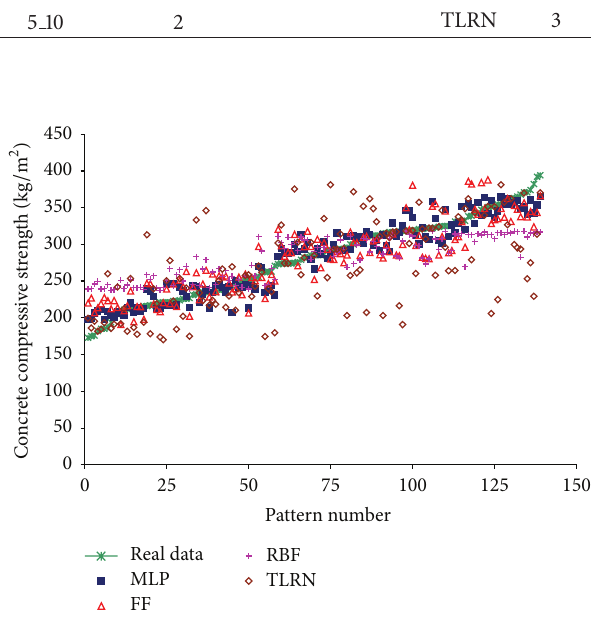
Figure2:Comparisonofobservedcompressivestrengthofconcrete calculated by EANN models in the training